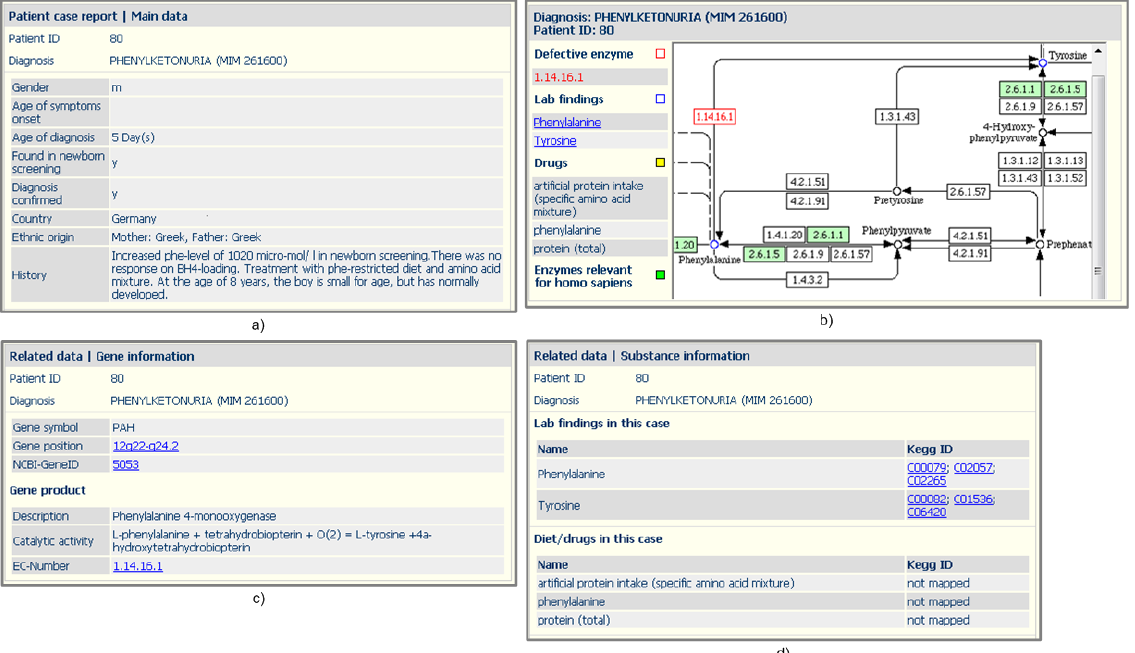
Figure 3: Screenshots of the web-based graphical user interface to access the integrated biomed- ical data in RAMEDIS with links to original data sources. a) General information of the case re- port, submitted by the author of the report. b) Case-specific representation of the related KEGG map with highlighted elements in di ff erent colors: a ff ected enzyme (red), quantified laboratory substances (blue). c) Related genetic information for specific disorder of the case report. d) Overview of biochemical substances in case report, appeared as laboratory substances or